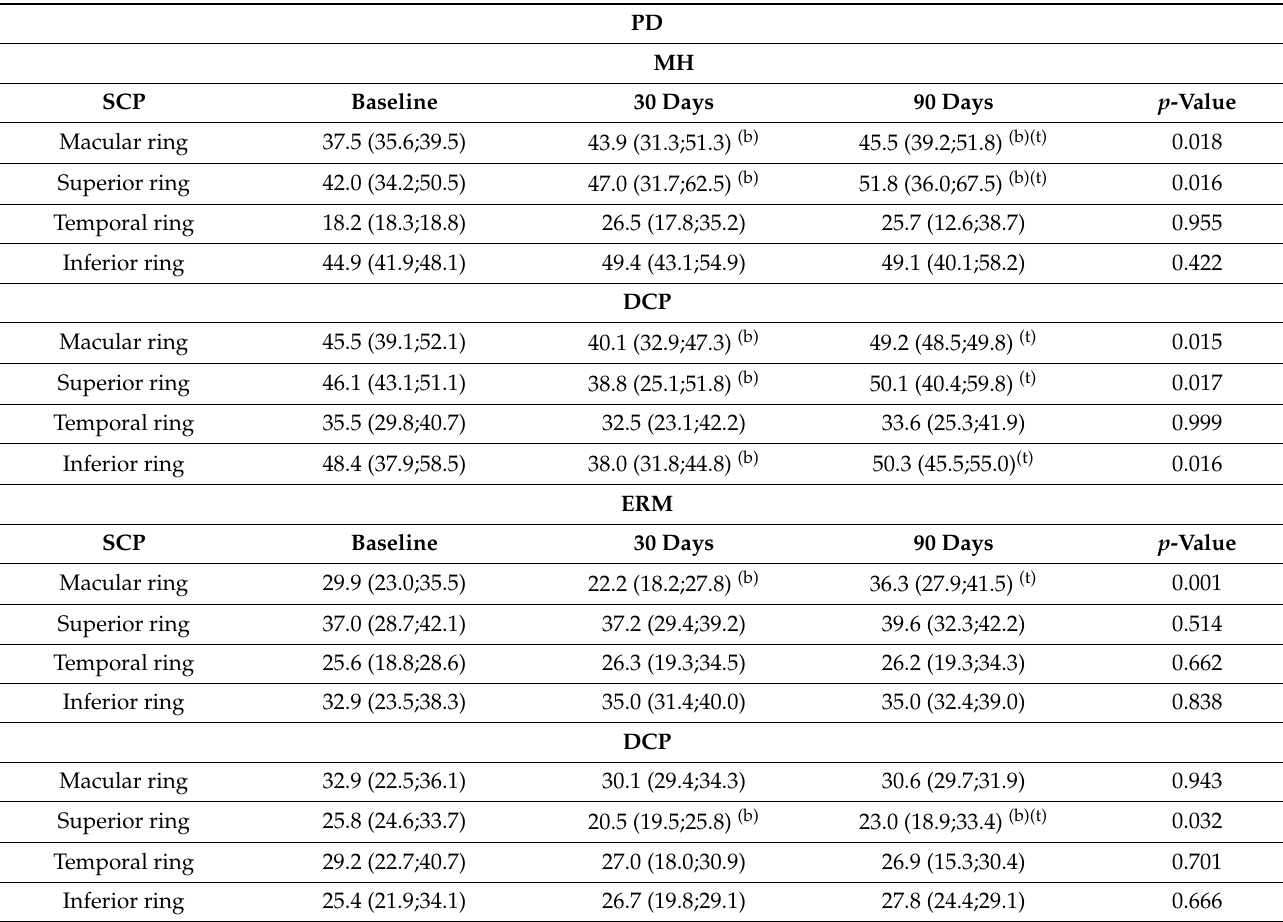
Table 2. Median and quartiles (Q1; Q3) for MH (macular hole) and ERM (epiretinal membrane) reported for baseline and up to 90 days, respectively, for every variable in the